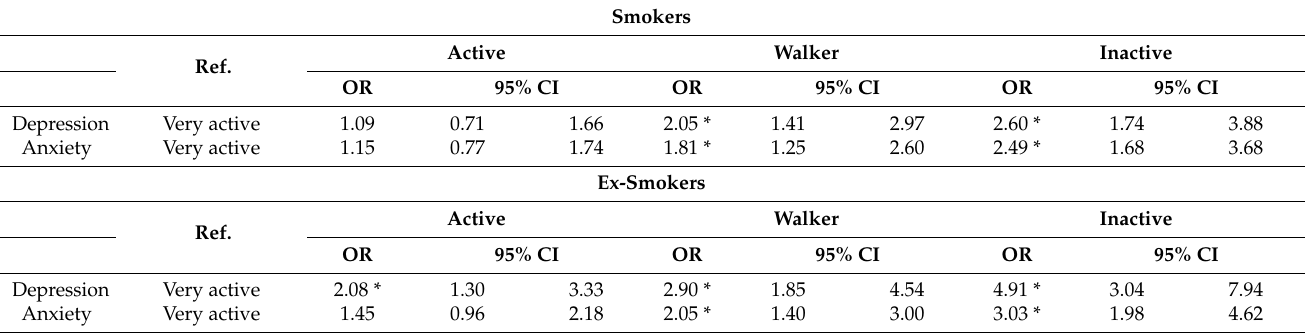
Table A7. Odd ratio of depression and anxiety, according to participants’ level of physical activity.